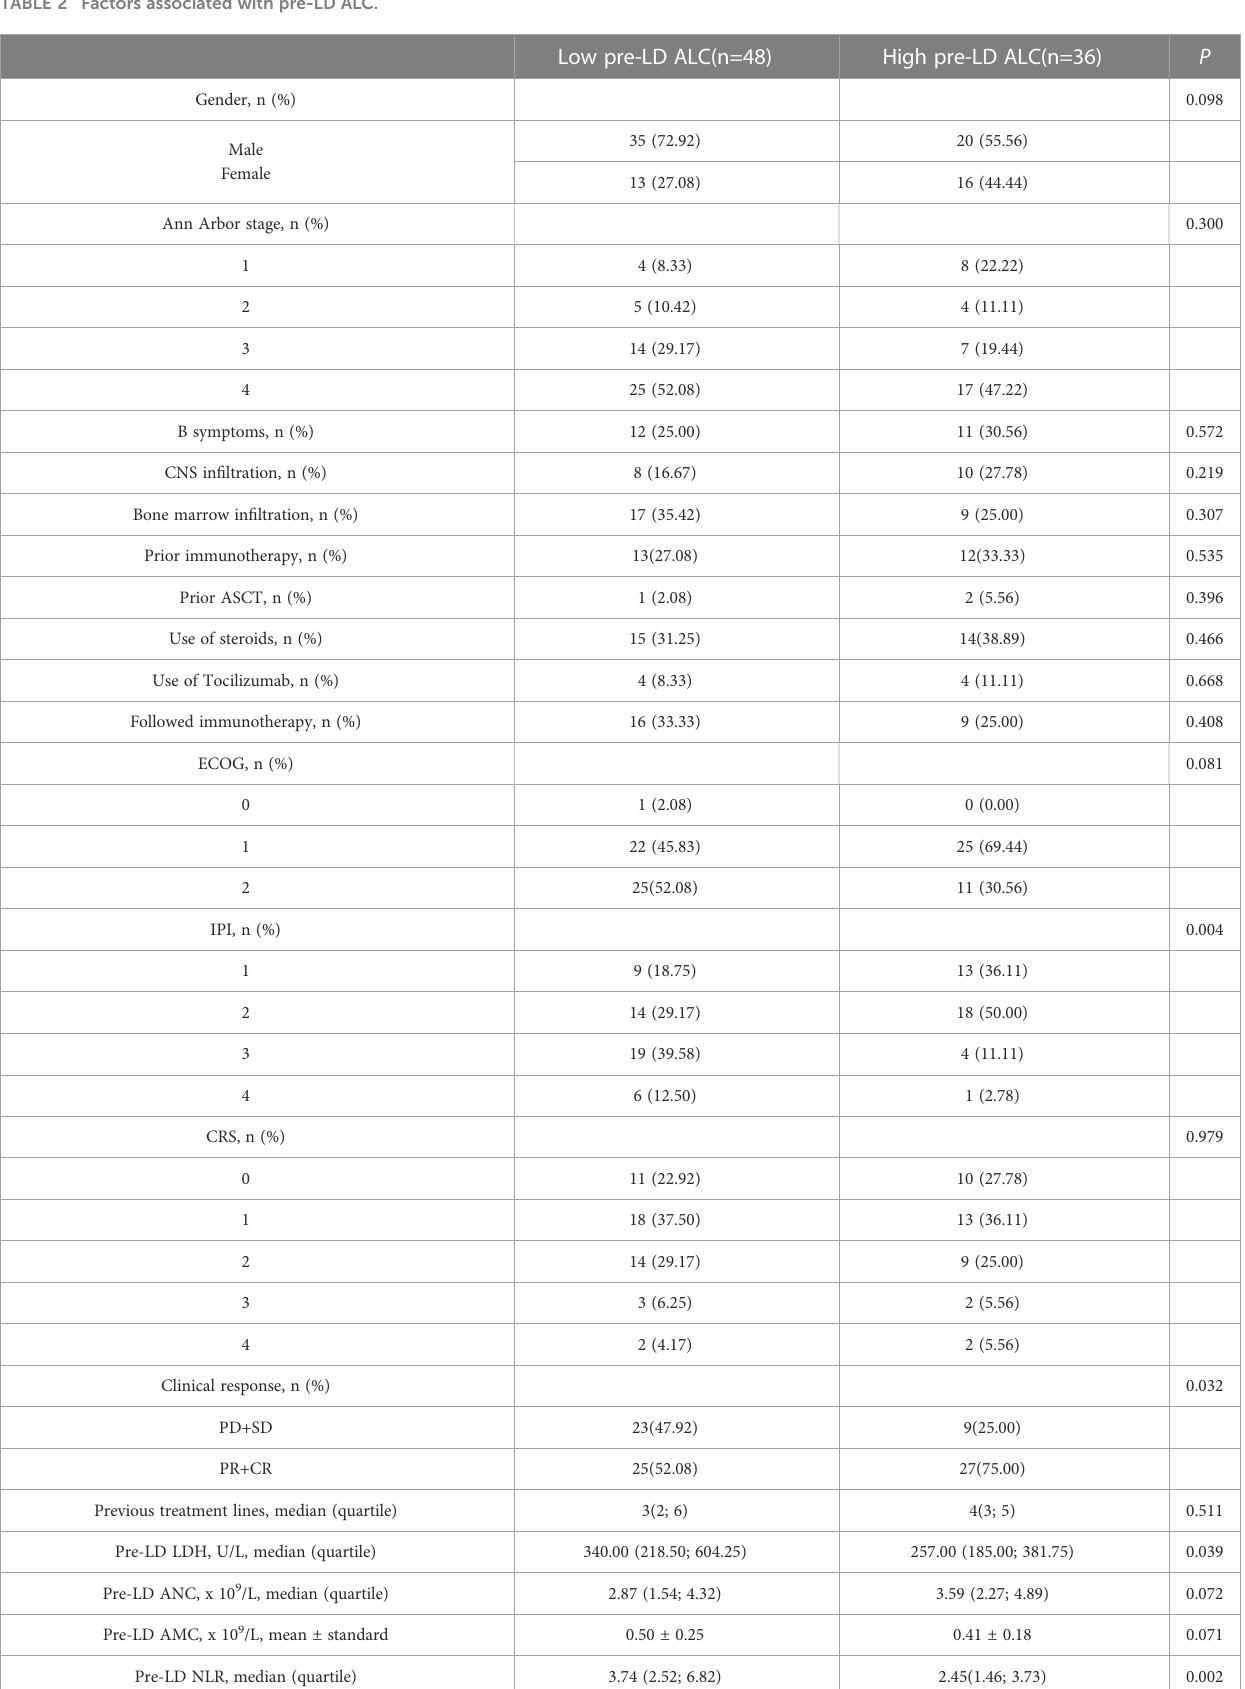
TABLE 2 Factors associated with pre-LD